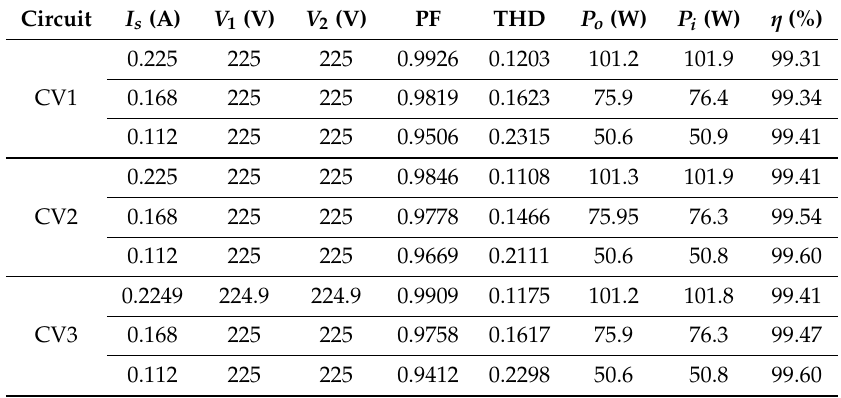
Table 3. Comparison results without capacitors